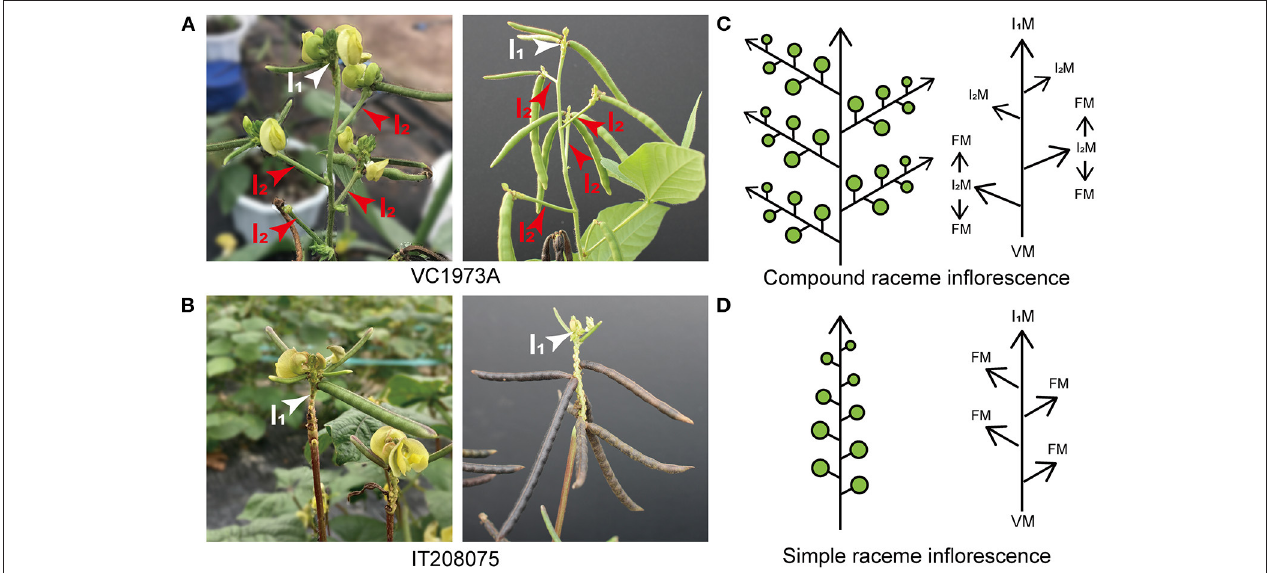
FIGURE 2 | Morphological differences in upper inflorescences between the parental lines VC1973A and IT208075. (A) VC1973A compound raceme (left photograph) and podding (right photograph). (B) IT208075 simple raceme (left photograph) and podding (right photograph). (C) Diagram showing compound raceme and meristem development. In the shoot apical meristem, the vegetative meristem (VM) is transferred to the primary inflorescence meristem (I 1 M), which then generates the secondary inflorescence meristem (I 2 M) to produce the floral meristem (FM). Flowers are borne along the secondary inflorescence (I 2 ) axes. (D) Diagram showing simple raceme and meristem development. Flowers are borne along the primary inflorescence (I 1 ) without generating secondary inflorescences. (A,B) White arrows indicate primary inflorescences; red arrows indicate secondary inflorescences. (C,D) Green circles represent flowers and pods.